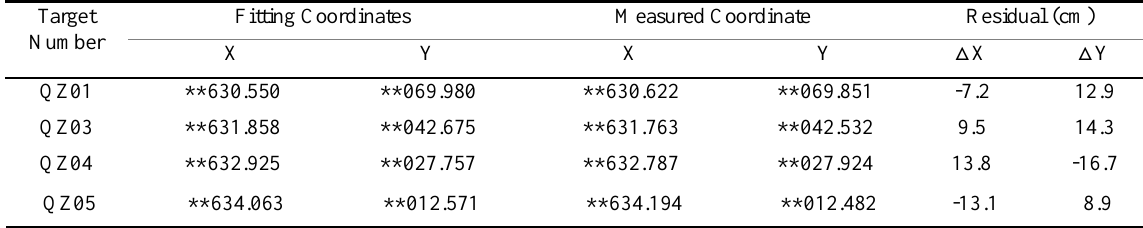
Table 2 The fitting coordinate and the measured coordinate